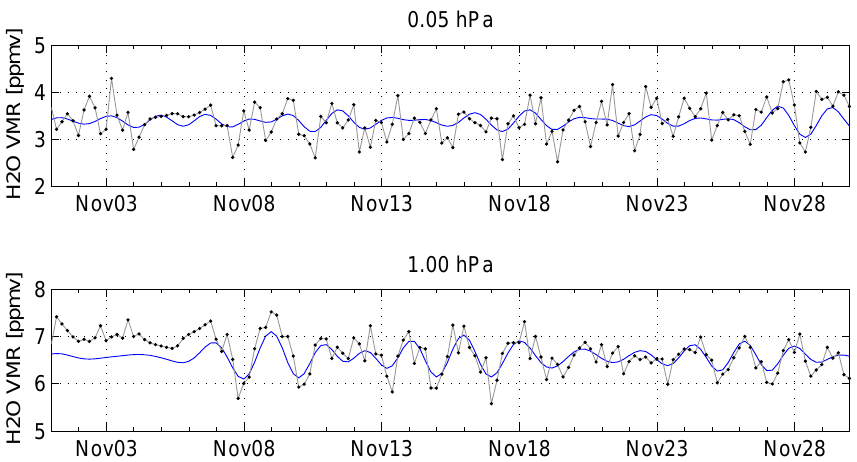
Figure 4. Measured water vapour data (black dots and grey lines) and filtered Q2DW signal (blue lines) for 0.05 and 1hPa for November 2011. The mean value over the time period has been added to the filtered signal and contributions with periods of 5, 10 and 16days have been subtracted from the measurement. In winter, the Q2DW is strong at 1hPa and accounts for most observed variations with periods shorter than 5days.